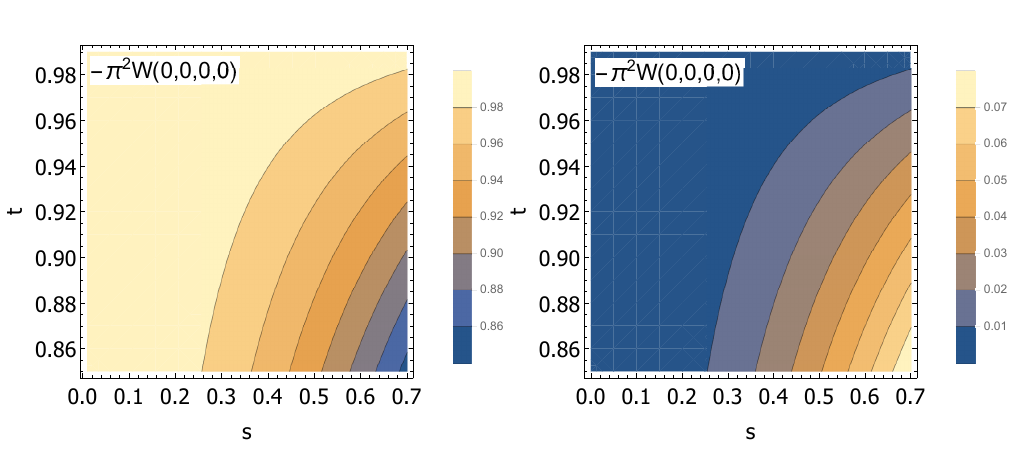
Figure 5. Plots of − π 2 W E (cid:48) ( 0,0,0,0 ) and heralding probability Pr on , of f for different values of squeezing s , weakly couplers transmission t . Left : − π 2 W E (cid:48) ( 0,0,0,0 ) vs. t - s with η = 1, ν = 1 and ζ = 1. Right : Pr on , of f vs. t - s with η = 1, ν = 1 and ζ = 1.